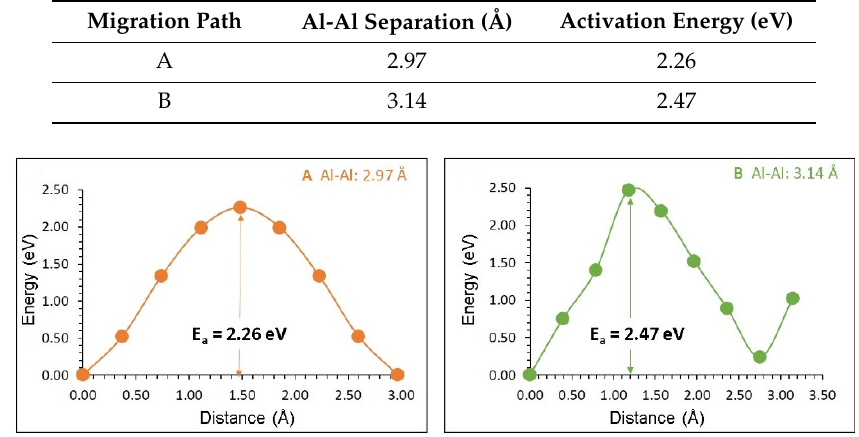
Figure 4. Two di ff erent energy profiles (as shown in Figure 3) of Al vacancy hopping between two Figure 4. Two different energy profiles (as shown in Figure 3) of Al vacancy hopping between two adjacent Al sites in Al 2 SiO 5 . adjacent Al sites in Al 2 SiO 5 .